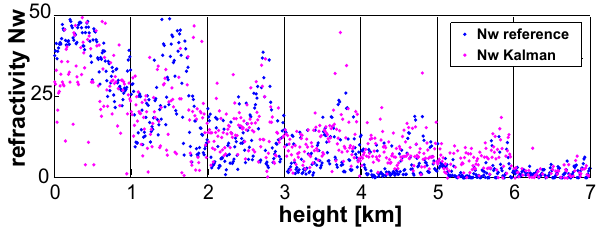
Fig. 15. The example of tomographic solution for one epoch during experiment. Cyan dots represent solution derived with Kalman filter and based on GNSS derived SWDs; blue dots obtained from NWP